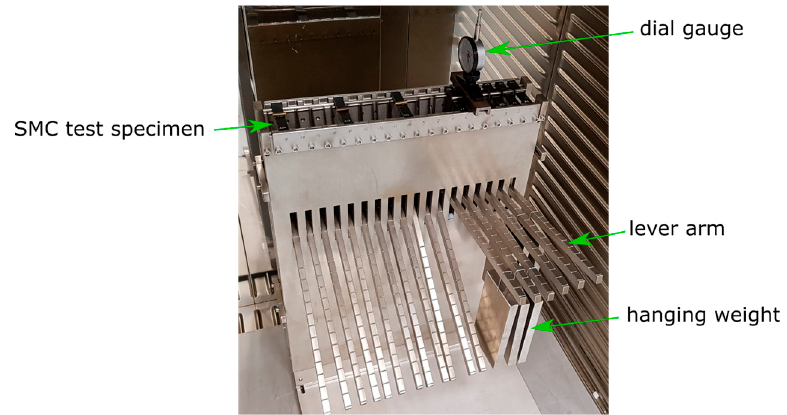
Figure 5. Deformation measurement with a dial gauge on the used flexural test fixture.